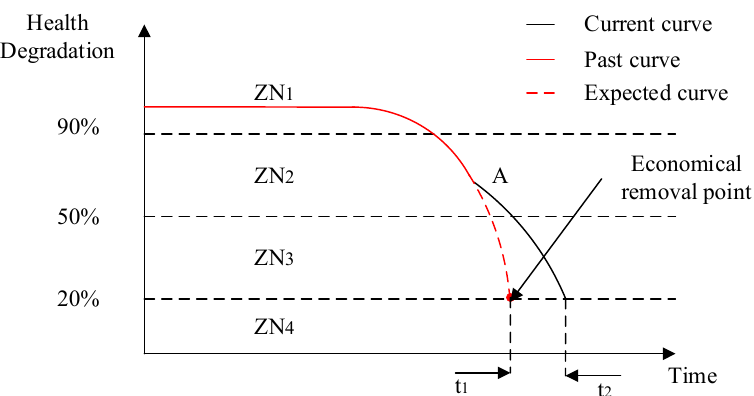
Figure 8. The variation of health degradation. Notes: ZN1 is the safe area; ZN2 is the wearing area; ZN3 is the high-risk area; ZN4 is the scrap area.